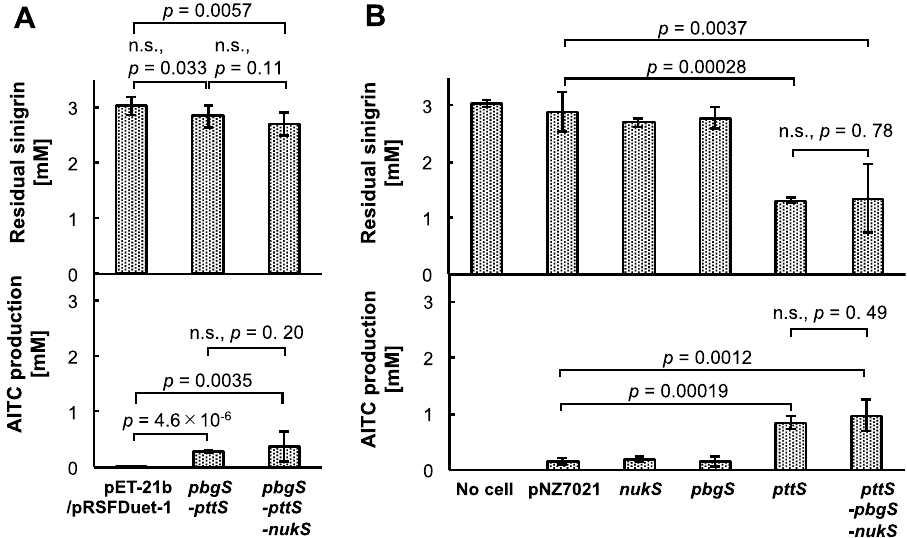
Figure 4. Sinigrin-degrading activity of transformed E. coli or Lc. lactis in the resting cell reactions using washed cells. ( A ) Amounts of residual sinigrin and produced AITC in the reaction mixtures using transformed E. coli . ‘pET-21b/pRSFDuet-1’ indicates the vector control strain; ‘ pbgS-pttS ’ indicates the strain pET21- pbgS / pRSFDuet- pttS and ‘ pbgS-pttS-nukS ’ indicates the strain pET21- pbgS /pRSFDuet- pttS-nukS. ( B ) Amounts of residual sinigrin and produced AITC in the reaction mixtures using transformed Lc. lactis. ‘No cell’ indicates a reaction solution without cells; ‘pNZ7021’ indicates the vector control strain; ‘ nukS ’ indicates the strain pNZ7021- nukS ; ‘ pbgS ’ indicates the strain pNZ7021- pbgS; ‘ pttS ’ indicates the strain pNZ7021- pttS ; ‘ pttS - pbgS - nukS ’ indicates the strain pNZ7021- pttS - pbgS - nukS . Data represent mean values (n = 3) . Error bars indicate 95% CI. Student’s t-test was performed for statistical analysis. n.s., no significant difference.